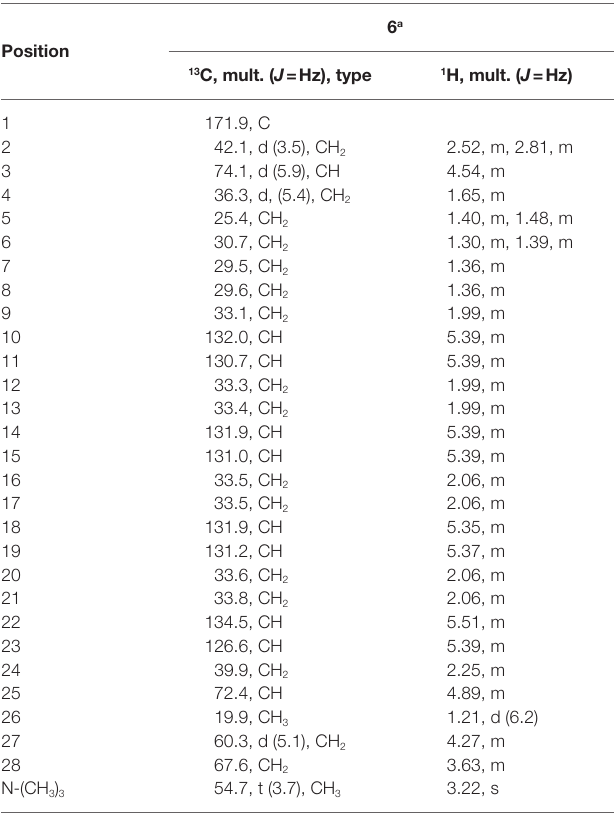
TABLE 4 | NMR spectral data of tropicicolide ( 6 ).